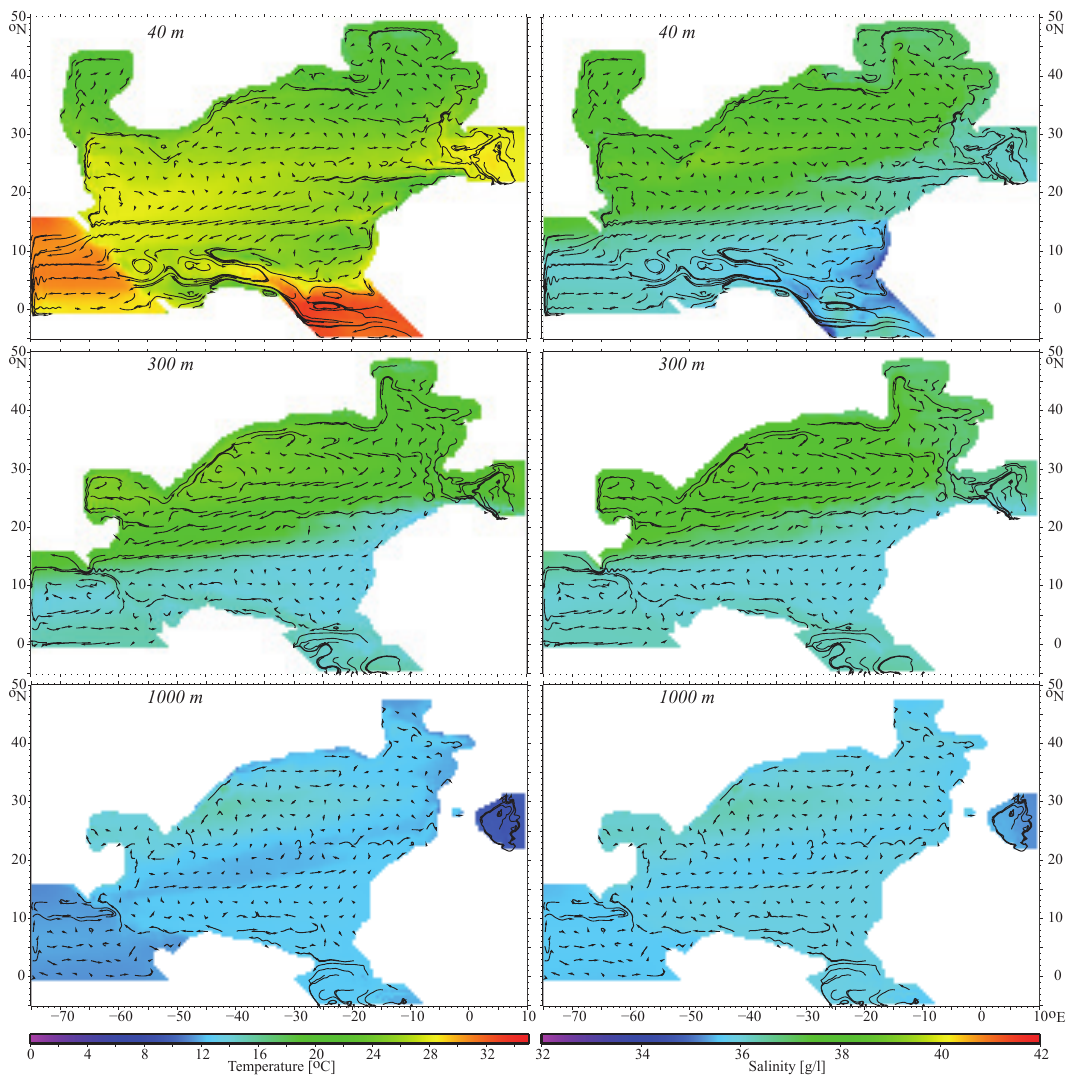
Fig. 8. SATL tracer patterns. Temperature (left) and salinity (right) slices taken at depths of 40, 300 and 1000m from the SATL experiment. Overprinted on the tracer colours are the paths of waterparticles of every fifth grid point followed for 42, 84 and 114